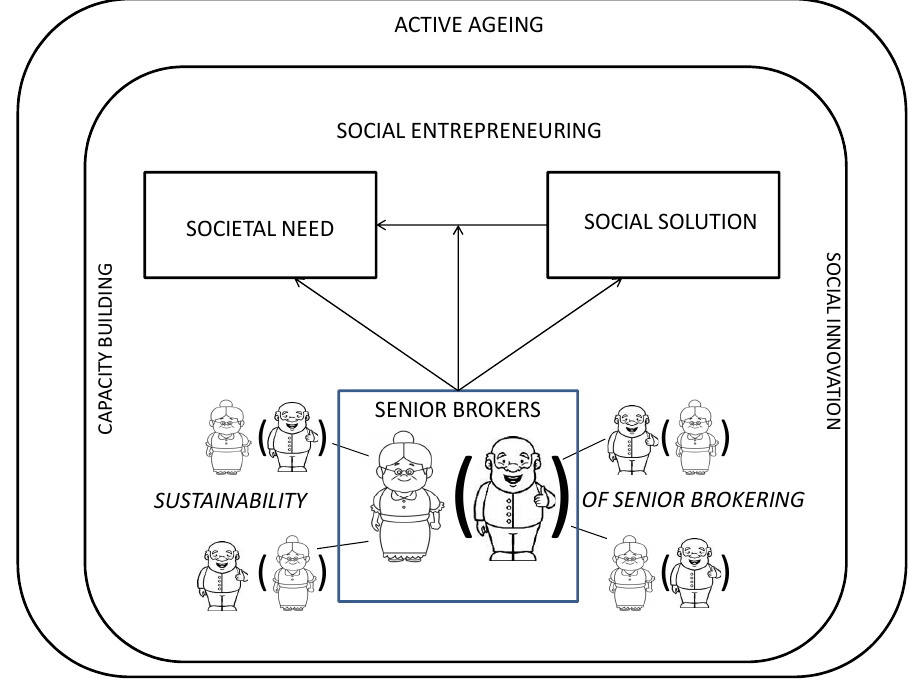
Figure 1. Senior social entrepreneuring: conceptual framework.